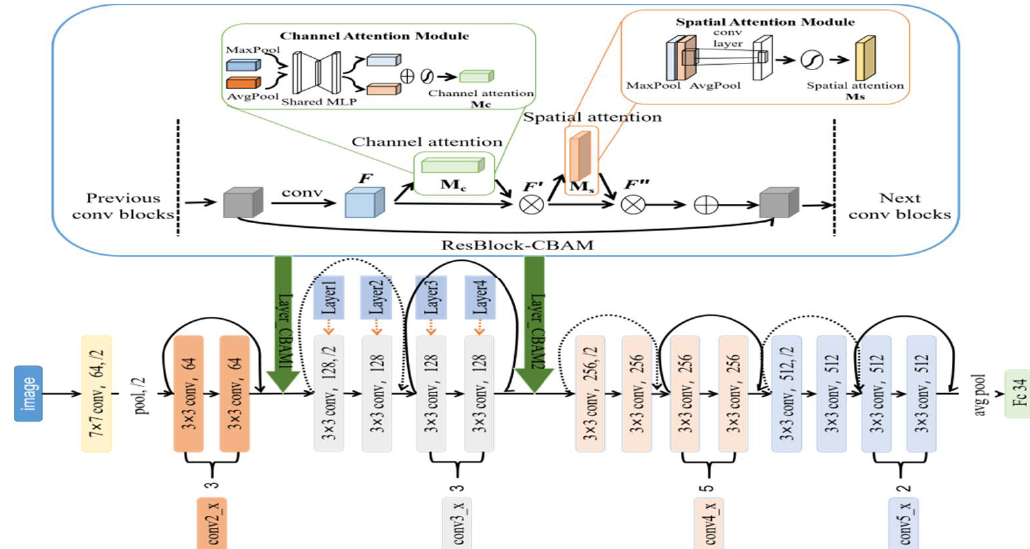
Figure 3. ResNet-CBAM model structure.